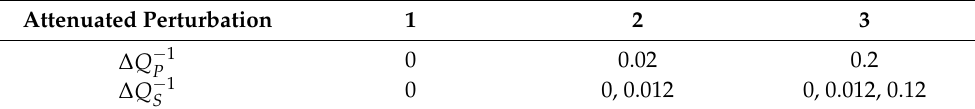
Table 4. The effect of attenuated isotropic perturbation on the reflection